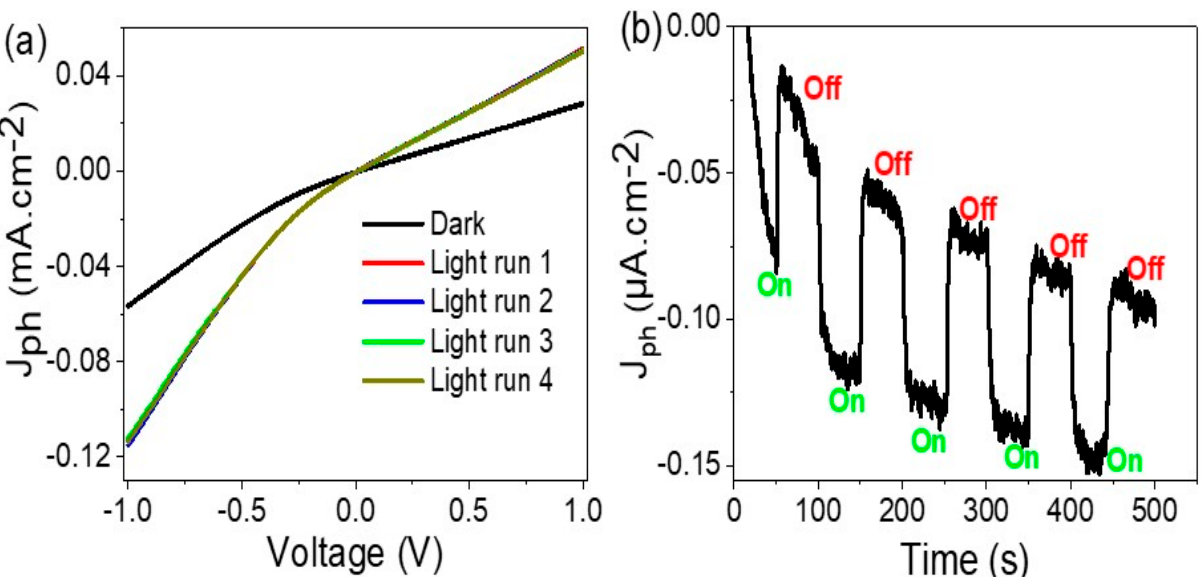
Figure 5. ( a ) The relation of voltage and current density and ( b ) the effect of chopped light illumi- nation on the prepared CuFeO 2 /CuO/Cu optoelectronic device at 100 mW·cm − 2 (solar simulator Xenon lamp).